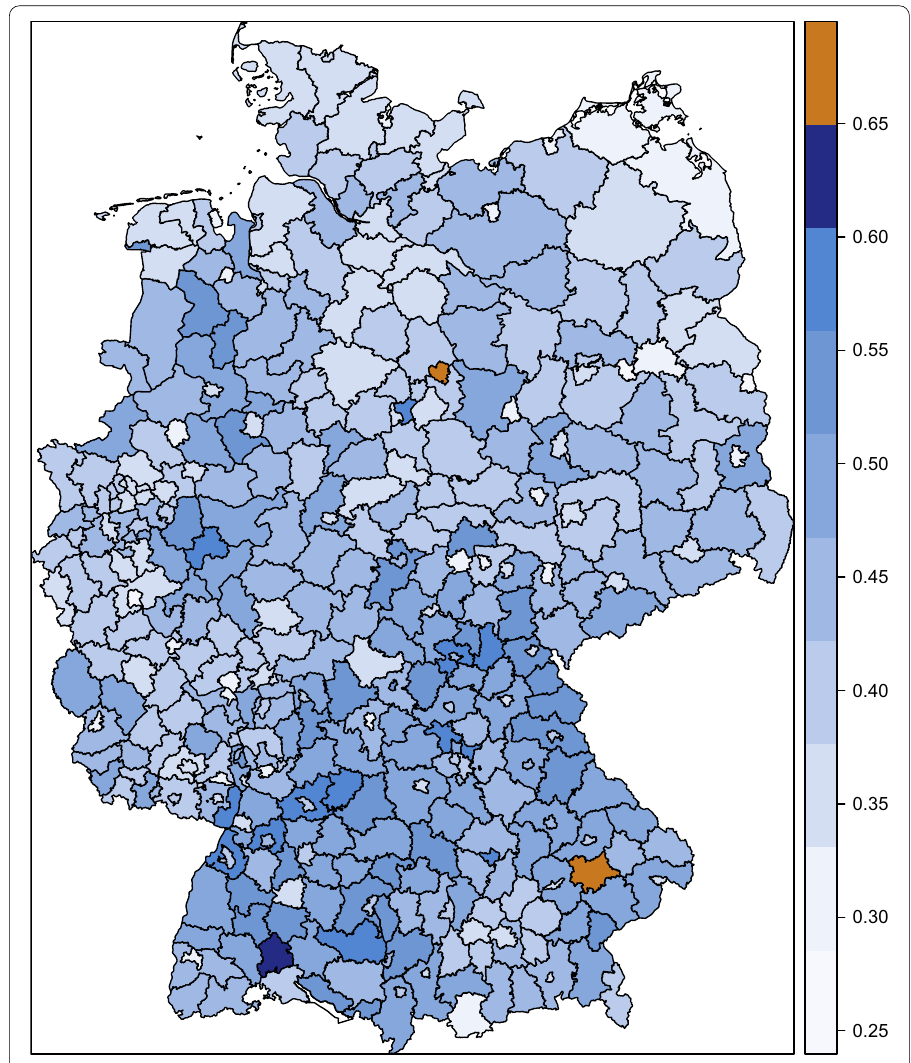
Fig. 6 Potential regional employment effects of a decline in UK import demand for final goods from the EU (no‑deal Brexit) in German counties. Employment effect in relation to total employment by county in percent. Source: World Input–Output Database, VGR der Länder (regional employment data) and own